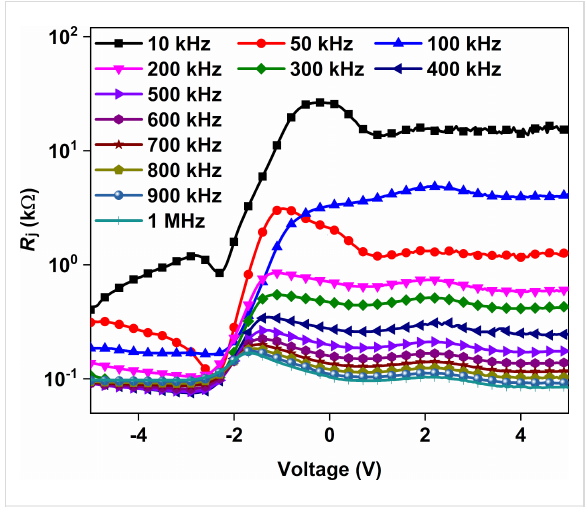
Figure 12: The R i – V plots of the Au/CuNiCoS 4 /p-Si photodiode for changing frequency.